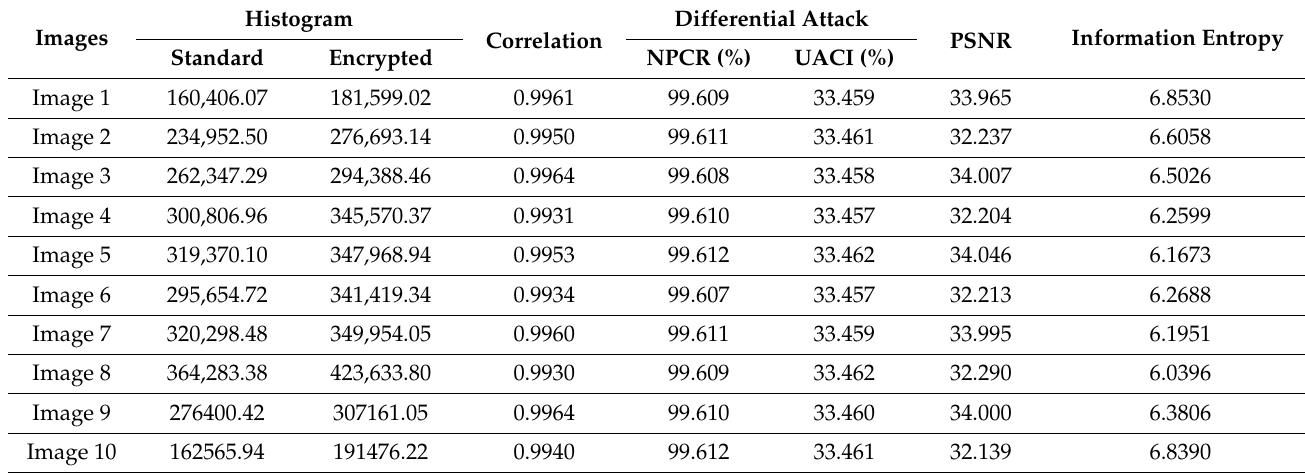
Table 5. Statistical metrics for CT Modality (Gaussian noise with 0.009